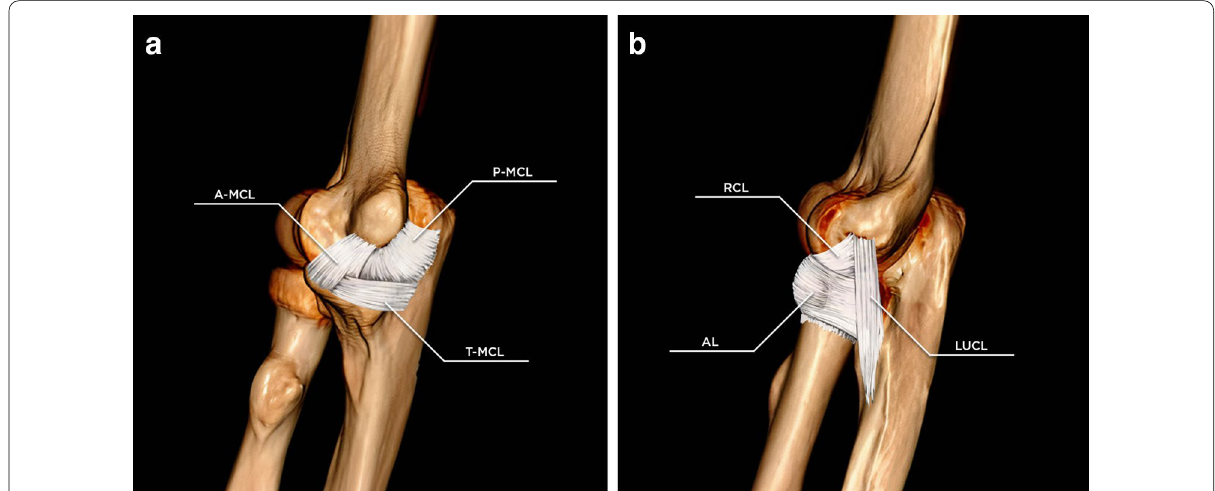
Fig. 1 Elbow 3D reformatting with ligament illustrations. Medial view ( a ). The medial collateral ligament (MCL) complex and its components: the anterior bundle of the medial collateral ligament (A-MCL), the posterior bundle of the medial collateral ligament (P-MCL), and the transverse ligament (T-MCL). Lateral view ( b ). The lateral collateral ligament (LCL) complex and its components: the radial collateral ligament (RCL), the lateral ulnar collateral ligament (LUCL), and the annular ligament